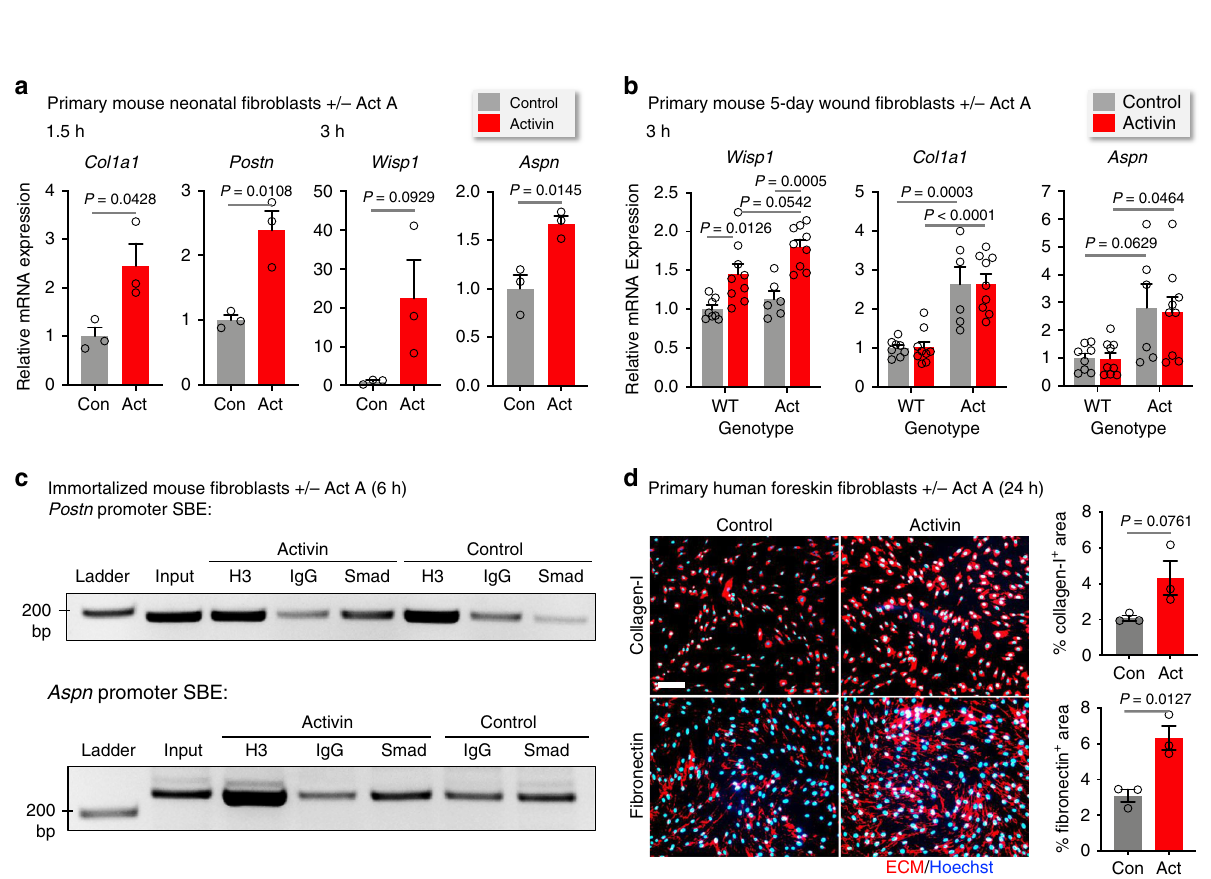
Fig. 4 Activin directly regulates pro- fi brotic ECM gene expression in fi broblasts. a qRT-PCR (relative to Rps29 ) using RNA from primary murine neonatal fi broblasts treated with activin A (20 ng/ml) or vehicle for 1.5 and 3 h. n = 3. b qRT-PCR using RNA from murine fi broblasts from 5-day wounds of adult WT and Act mice treated with activin A (20 ng/ml) or vehicle for 3 h. n = 8, 9, 6, 9 for WT-control, WT-Activin, Act-Control, and Act-Activin, respectively. c Chromatin immunoprecipitation from lysates of immortalized mouse fi broblasts treated with activin A (20 ng/ml) or vehicle for 6 h. Antibodies against anti-histone H3 (H3) or Smad2/3 (Smad) or normal rabbit IgG (IgG) were used. The bound DNA was ampli fi ed using primers spanning conserved Smad- binding elements (SBEs) in the promoter regions of Postn and Aspn (see Supplementary Fig. 4b). Representative agarose gels are shown, with the size marker and respective inputs. The experiment was repeated twice with similar results (see also Supplementary Fig. 4c). d Representative photomicrographs of human primary foreskin fi broblasts treated with activin A (20 ng/ml) or vehicle for 24 h and stained for collagen type I or fi bronectin (red) (nuclei were counterstained with Hoechst (blue)). Bar graphs show quanti fi cation of the percentage of the stained area. Scale bars: 200 μ m. n = 3. Graphs show mean ± SEM and P values; mean expression levels in control cells ( a ) or control cells in WT mice ( b ) were set to 1; two-tailed Student's t- test ( a , d ), one-way ANOVA and Tukey ’ s multiple comparison post hoc tests ( b ). All n numbers indicate biological replicates. Source data are provided as a Source Data fi le (Fig.